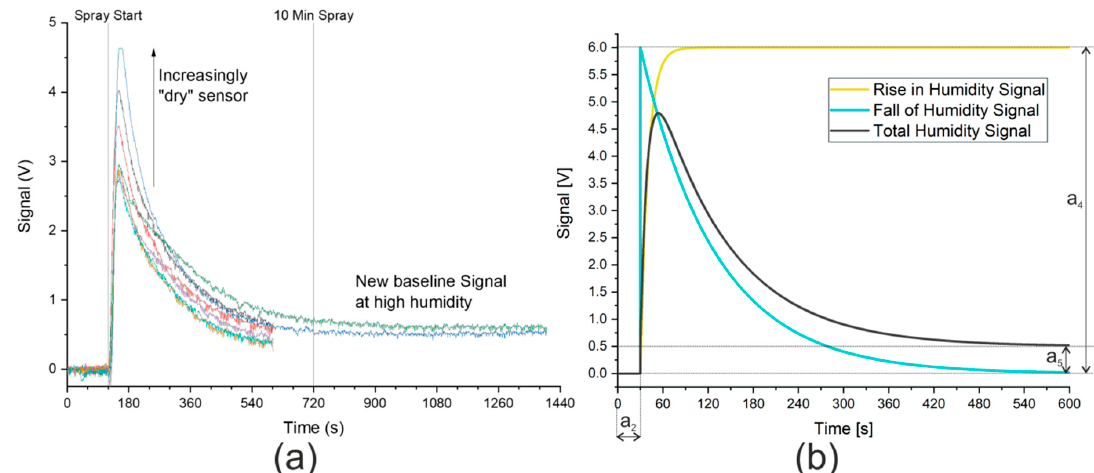
Figure 2. ( a ) Signal from ammonia sensor owing to gas stream saturated with water. Synthetic air with 5% relative humidity (purge gas) measured until spray start at 120 s. Saturated gas stream then continuously measured until end of data. Signal from hydrogen sulfide sensor is analogous and is shown in Figure S5. Ten min spray time marked to show the manufacturer’s recommended time to acclimatize to new humidity level. ( b ) Model describing signal caused by humidity. Coefficients: a 2 = 30 s, a 4 = 6 V, a 5 = 0.5 V. Rise in humidity signal modeled against humidity measurements, as shown in Figure S6.